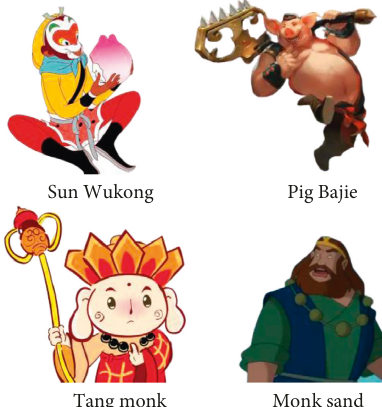
Figure 6: Animation character modeling in “Havoc in